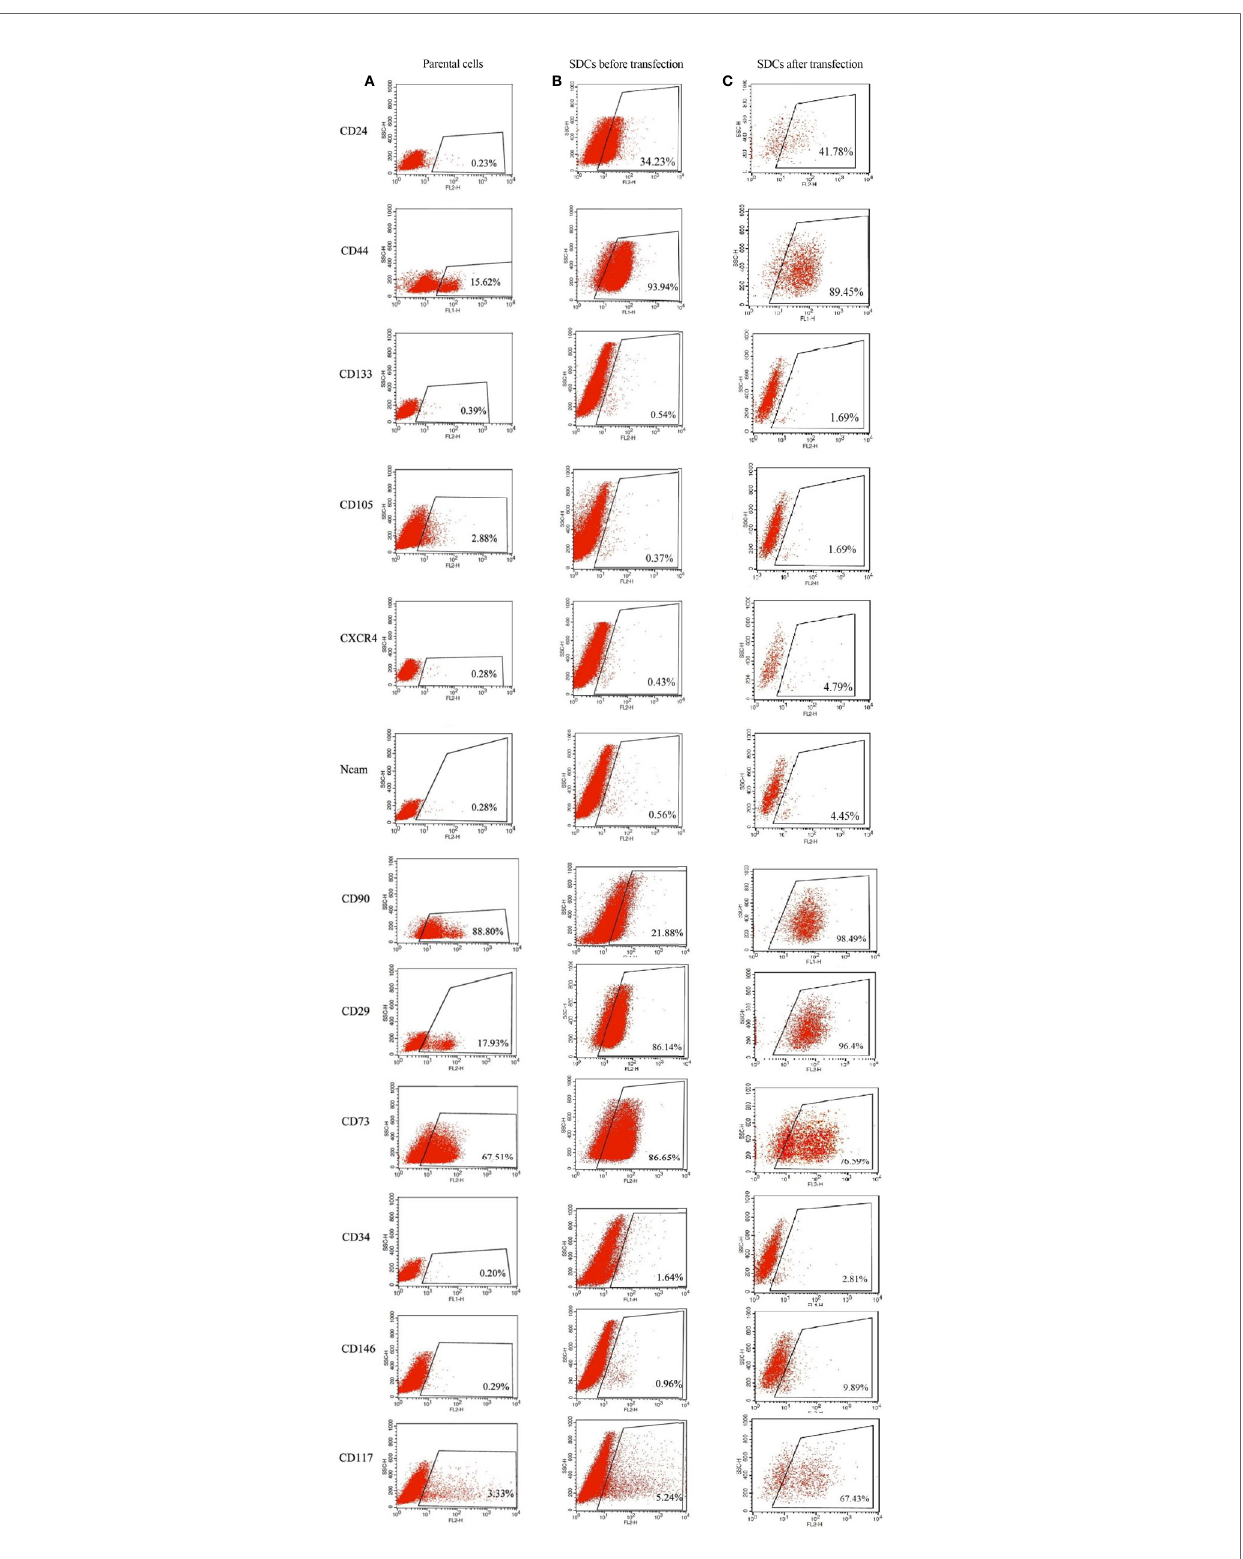
FIGURE 6 | Expression Levels of Putative CSC Markers in Parental Cells (PCs) and Pre transfected and Post Transfected Spheroid-Derived Cells (SDCs) Using Flow Cytometry. (A) Expression of CSC markers in PCs. (B) Expression of CSC markers in SDCs before transfection with SiSMAD4. (C) Expression of CSC markers in SDCs after transfection with SiSMAD4. Data are represented as mean ± SD (n = 3